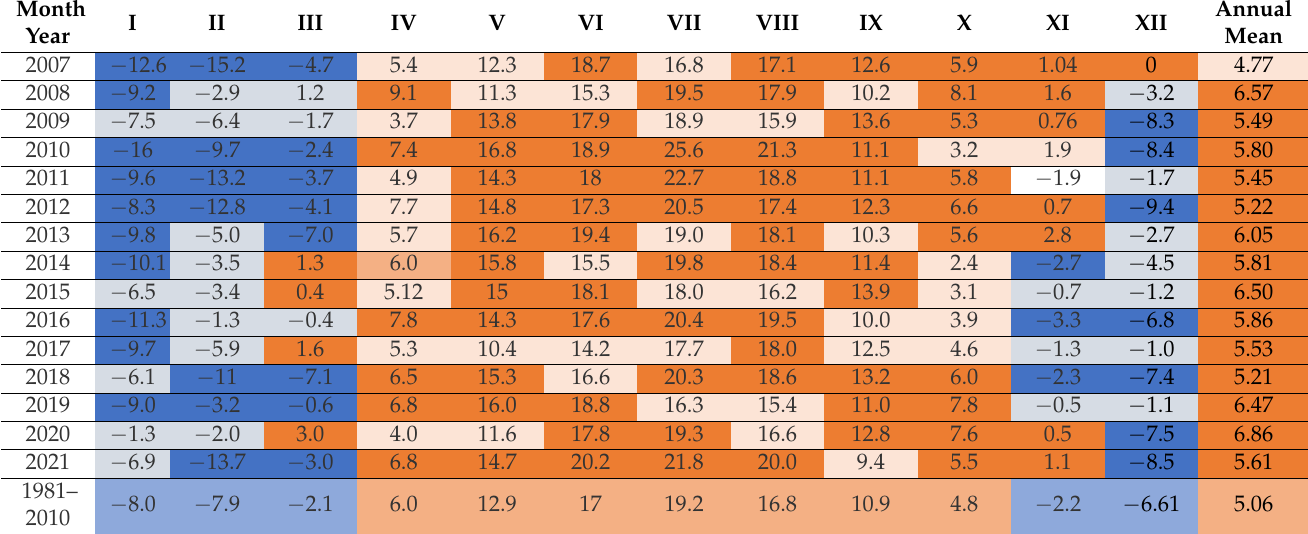
Table 3. Average monthly and mean annual air temperature for the observation period and their average values for the 30-year period (1981–2010). The colour intensity indicates the degree of negative (blue) or positive (orange) deviation from the average temperature